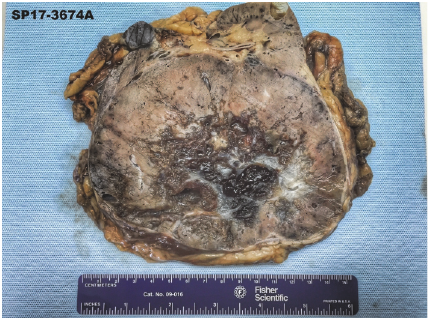
Figure 4: Gross specimen of right kidney containing maroon- colored mass with gray-white central